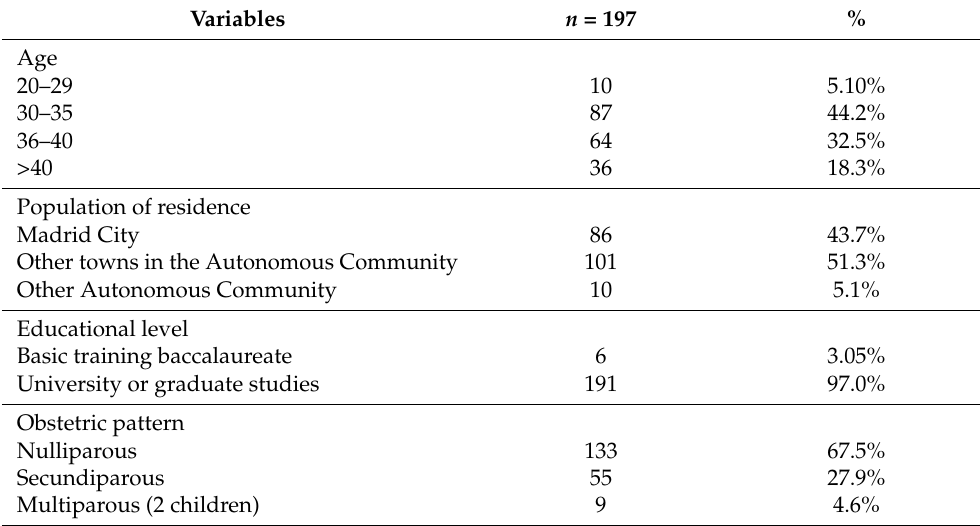
Table 1. Sociodemographic variables.